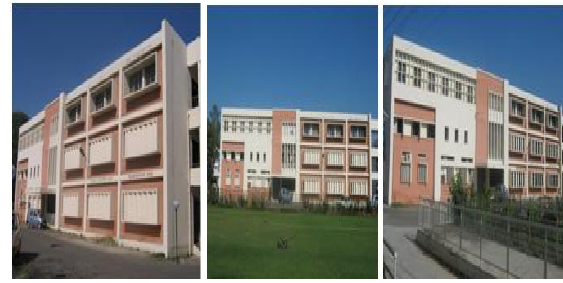
Figure 4. Showing photographs for multi-images project (for Photomodeler software)